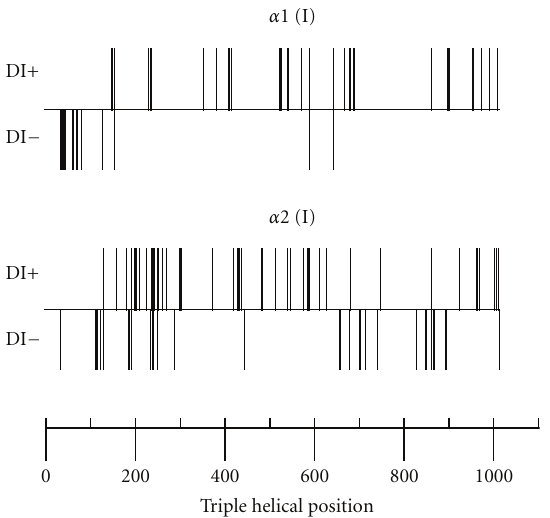
Figure 3: Relationship between the triple helical position of glycine mutations in collagen type I α chains and the presence (+) or absence ( − ) of blue sclera, adapted from